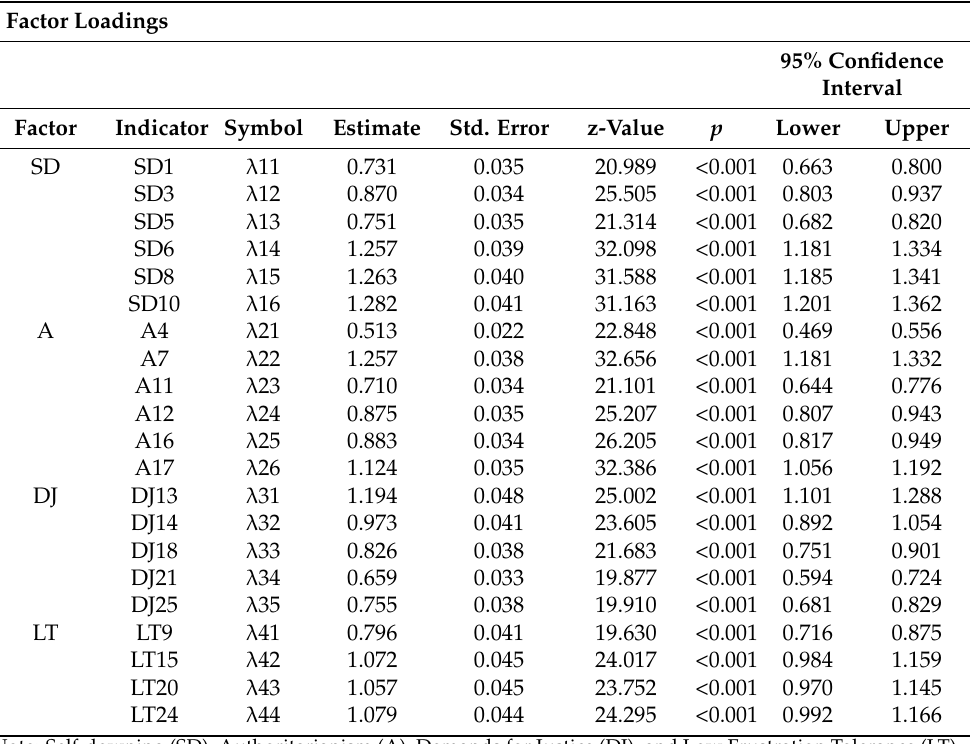
Table 6. CFA measurement model for women: Factors, estimates of factor loadings, standards errors, and statistical